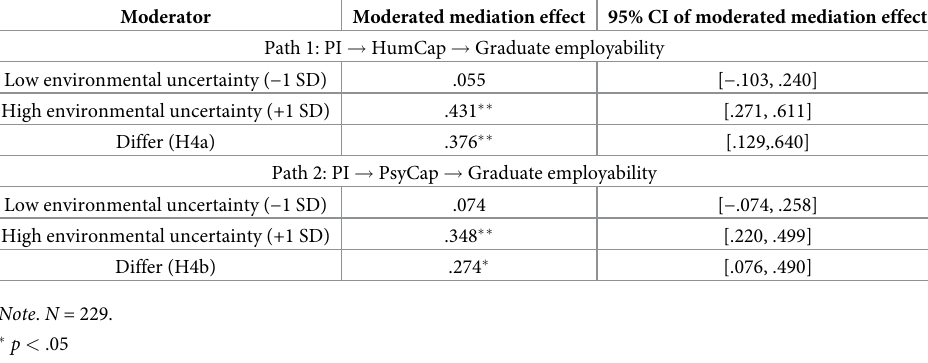
Table 5. Conditional indirect effects of PI on graduate employability at values of environmental